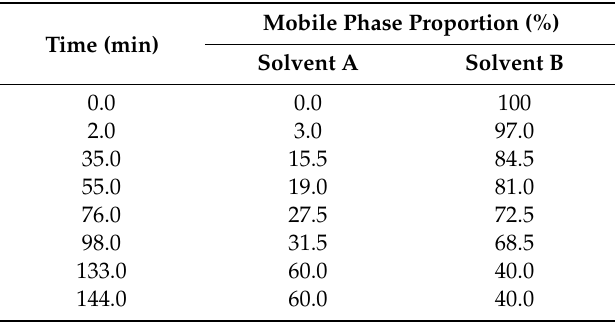
Table 2. Gradient system used to isolate compounds on preparative HPLC. Time